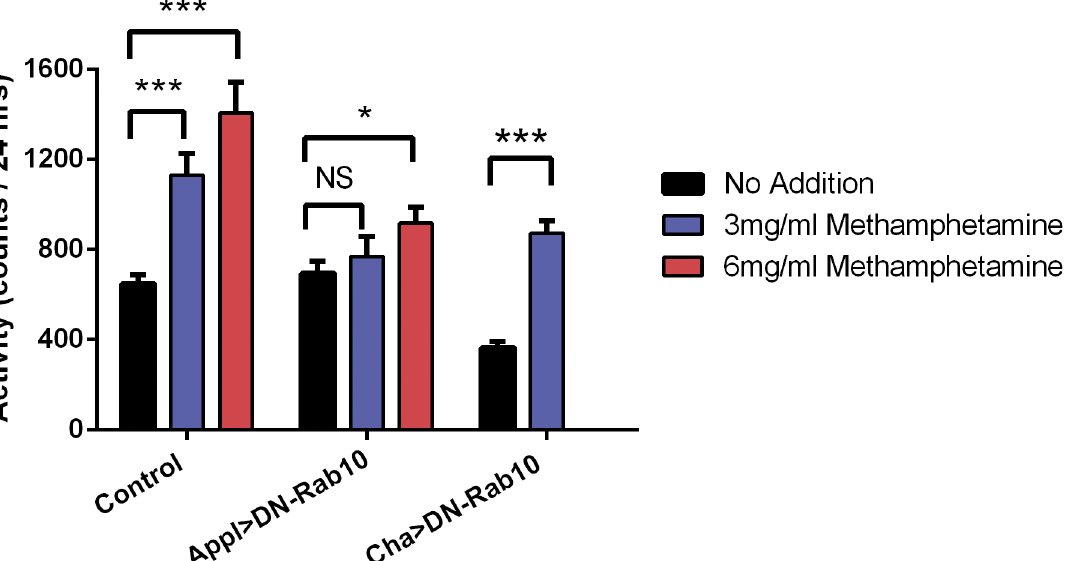
Fig 4. Rab10 is required for methamphetamine-induced activity in D . melanogaster . Flies were fed methamphetamine mixed into their food at the indicated concentration. The activity of the flies was continuously monitored and the total activity for the second 24 hr period tallied. Results (mean ± SEM, n = 28 – 30) are shown for control flies and flies expressing DN-Rab10 in all neurons (Appl > DN-Rab10) or selectively in cholinergic neurons (Cha > DN-Rab10). * p < 0.05, *** p < 0.001 compared to activity in flies fed a control diet. For pan-neuronal expression, two-way ANOVA: F (2, 172) = 16.68, p < 0.0001 for methamphetamine dose, F (1, 172) = 14.88, p = 0.0002 for genotype. Holm- Š ídák multiple t-test: t-ratio (df) = 4.67 (58), 0.72 (58) and 8.35 (30) for comparing control, Appl > DN-Rab10 and Cha > DN-Rab10 genotypes respectively at 3 mg/ml and 5.54 (56) and 2.47 (58) for control and Appl > DN-Rab10 genotypes at